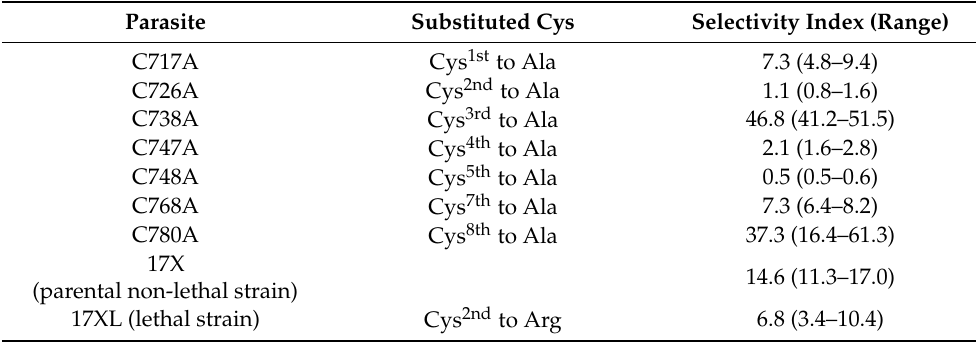
Table 1. Selectivity index of wild-type and transgenic parasite